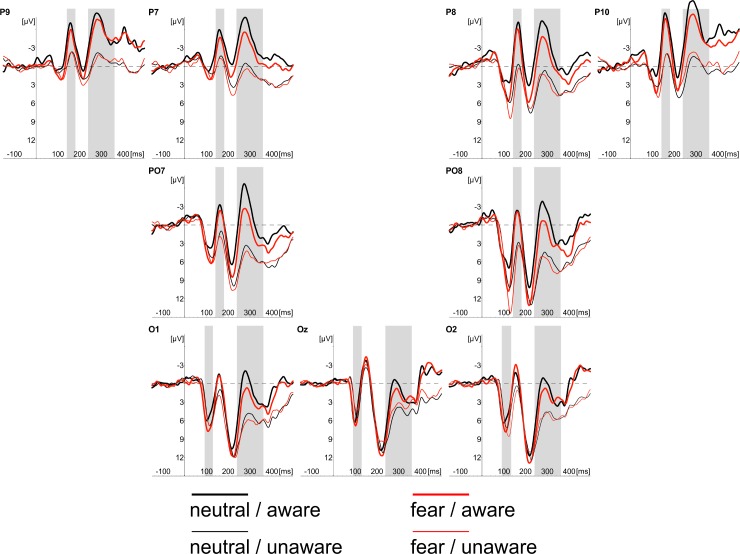
Grand average of ERPs recorded in CR task at occipital (O1, Oz, O2) and occipito-temporal (P7, PO7, P9, P8, PO8, P10) electrodes in response to neutral (black lines) and fearful faces (red lines).Responses obtained in “unaware” (thin lines) and “aware” trails (thick lines) are also shown. Time windows for the region of interest (P1 component; 90-115ms post-stimulus; N170 component; 145-180ms post-stimulus; EPN component 240–340 ms post-stimulus) are highlighted at corresponding electrodes; time 0 indicates stimulus onset.